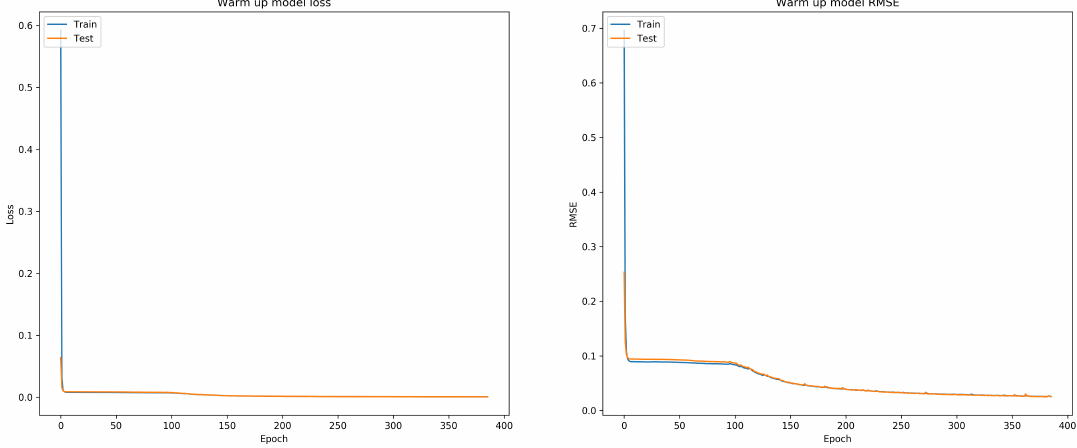
Figure 7. Warm-up training on Beijing transportation smart card data. Left : The two curves denote training loss and validation loss, respectively. Right : The two curves denote training normalization root mean square error (RMSE) and validation normalization RMSE,